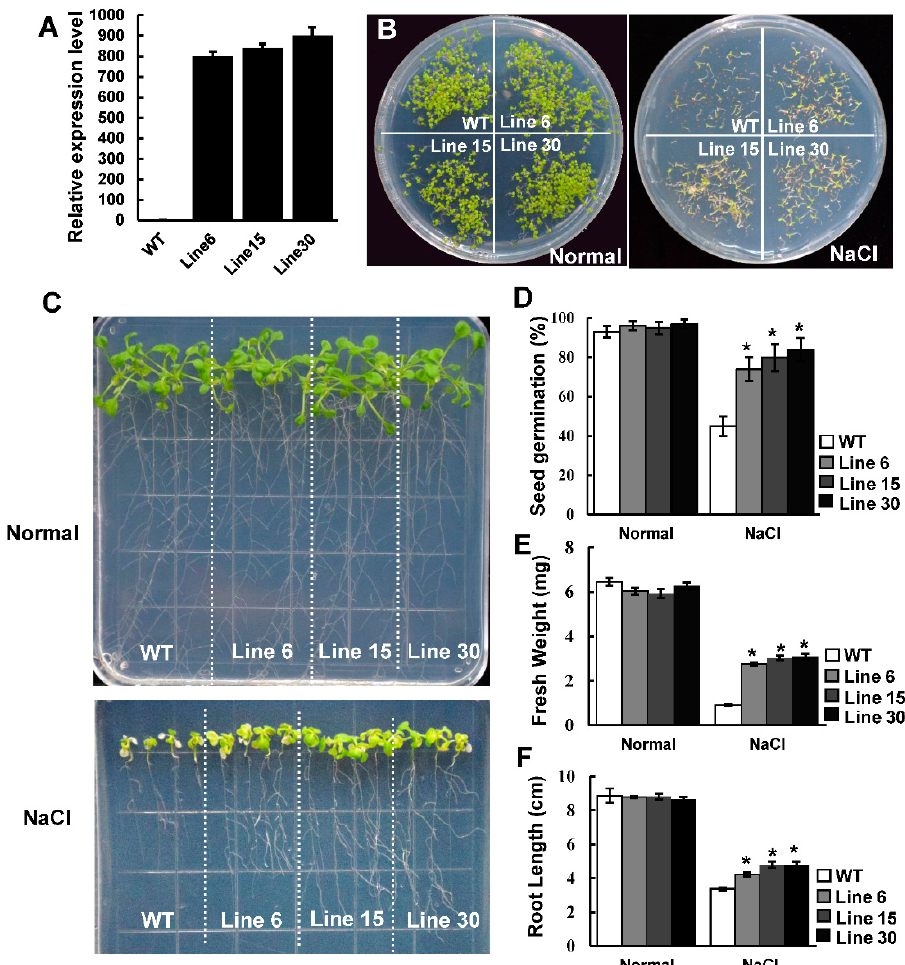
Figure 4. Salt tolerance analysis in panel growth condition. ( A ) qRT-PCR analysis of PtSAP13 expression in wild-type (WT) and transgenic plants. ( B ) Seed germination of WT and transgenic lines under normal and salt medium. ( C ) Photograph of WT and transgenic seedlings under normal and salt treatment medium. ( D – F ) Measurement of the seed germination ( D ), fresh weight ( E ), and root length ( F ) of WT and PtSAP13 -overexpressing plants under normal condition and stress treatments. Error bars indicate the standard deviations, and * indicate significant differences compared with WT at the p < 0.05 level.